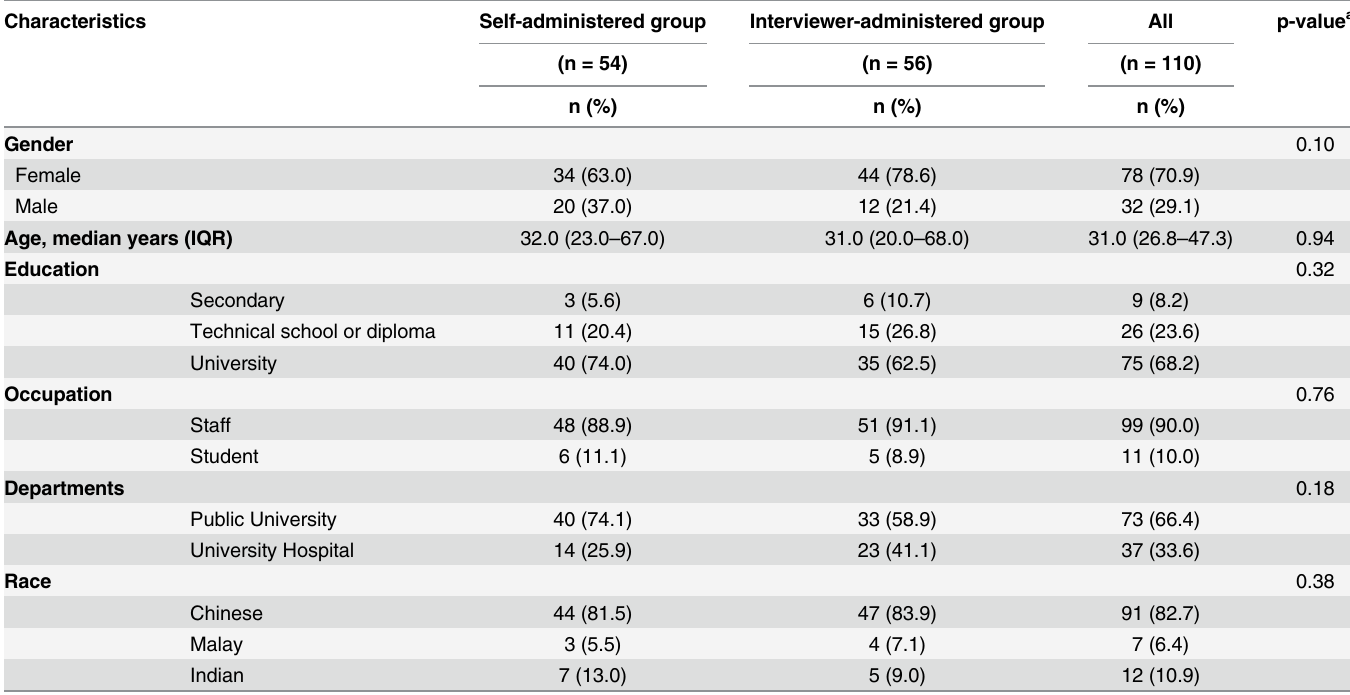
Table 1. Characteristics comparison of self- vs. interviewer-administered